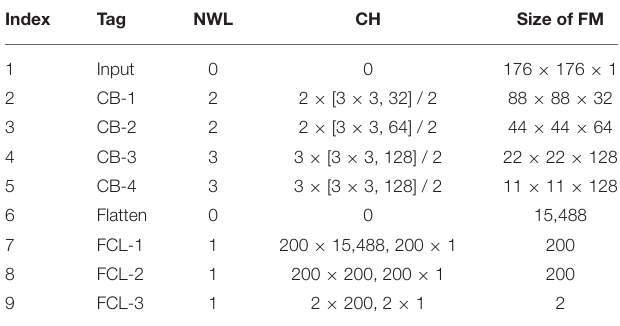
TABLE 3 | Arrangement of our 13-layer VIN.